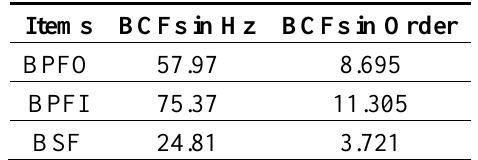
Table 2. BCFs of the